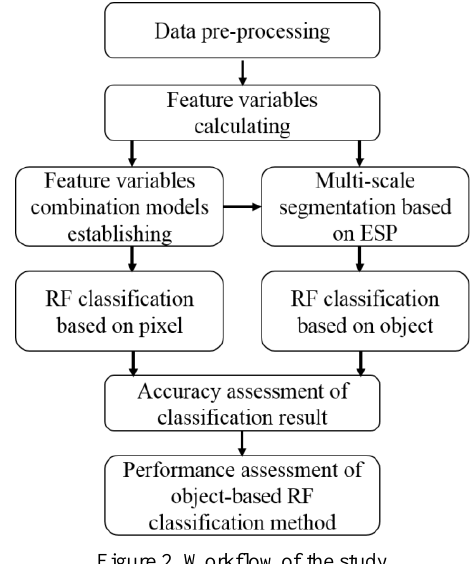
Figure 2. Workflow of the study